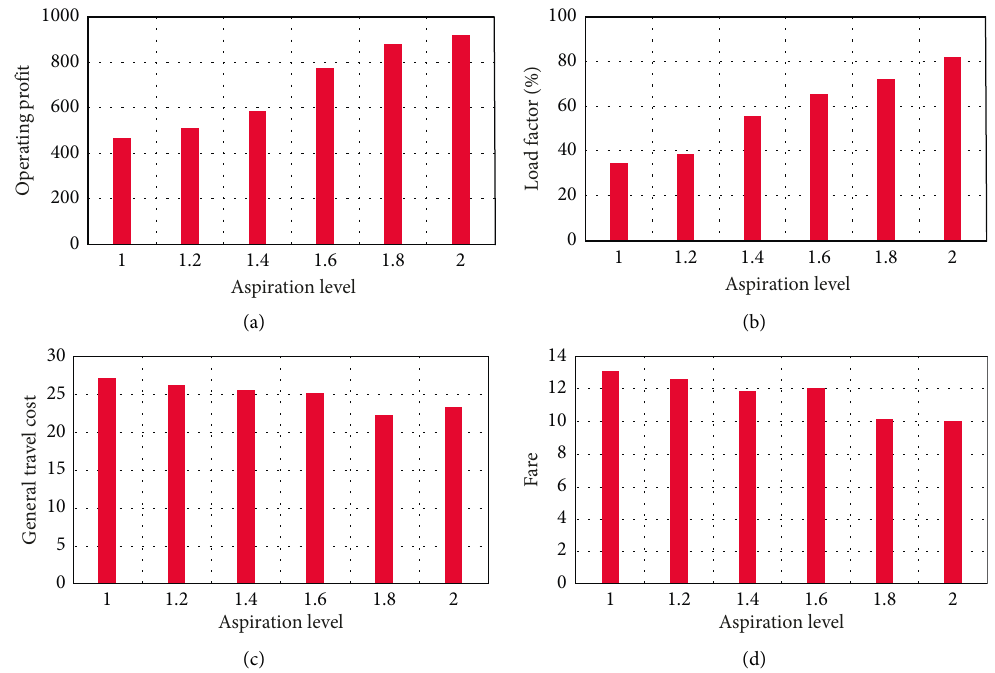
Figure 8: Sensitivity analysis of the aspiration level. (a) Operating profit. (b) Load factor. (c) General travel cost. (d)